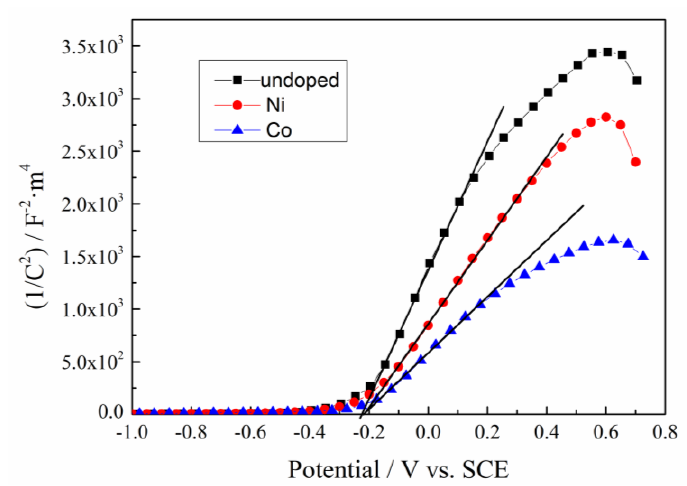
Figure 8. Mott–Schottky plots of the α -Fe 2 O 3 nanorod arrays.